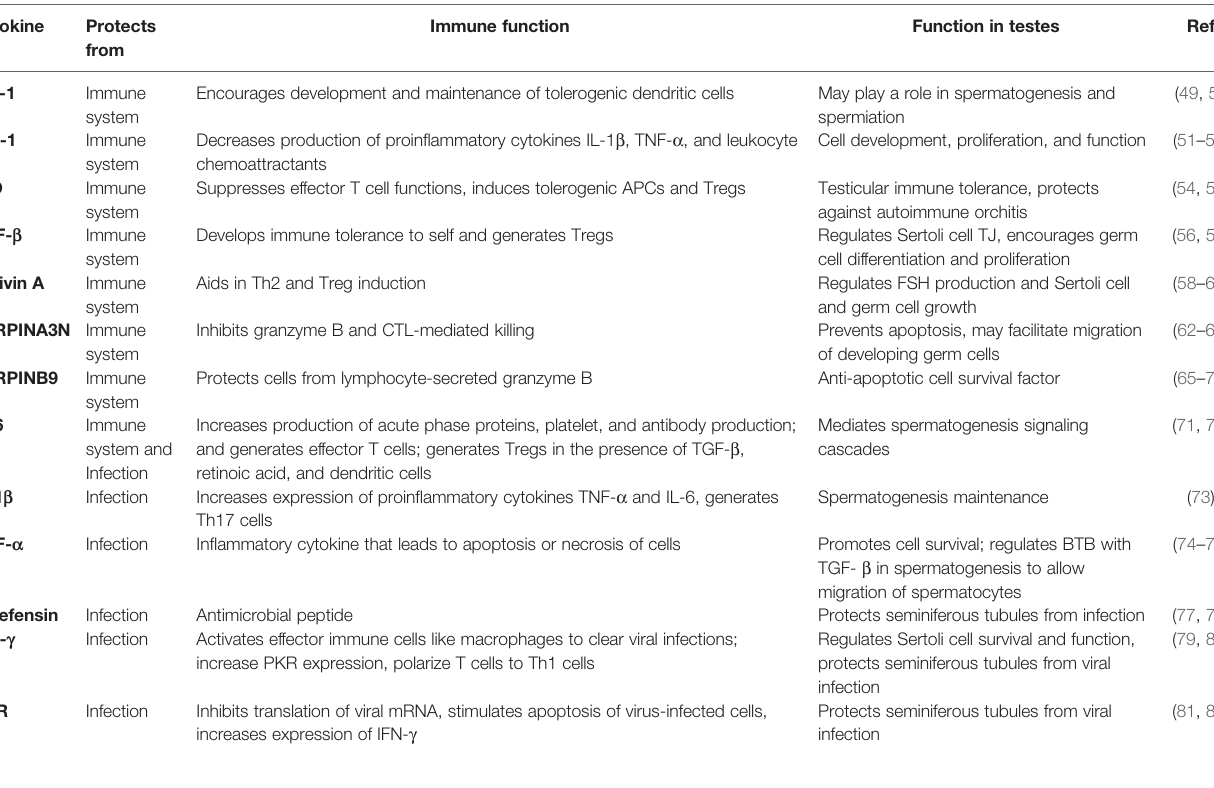
TABLE 1 | Selected immunomodulatory factors expressed by Sertoli